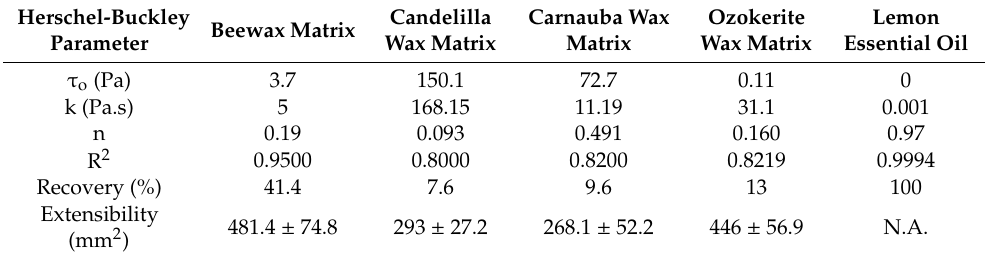
Table 4. Herschel–Buckley parameters and thixotropic recovery from the stress-strain profiles at 25 ◦ C. Candelilla Carnauba Wax Ozokerite Lemon Herschel-Buckley Beewax Matrix Wax Matrix Matrix Wax Matrix Essential Oil Parameter τ o (Pa) 3.7 150.1 72.7 0.11 0 k (Pa.s) 5 168.15 11.19 31.1 0.001 n 0.19 0.093 0.491 0.160 0.97 R 2 0.9500 0.8000 0.8200 0.8219 0.9994 Recovery (%) 41.4 7.6 9.6 13 100 Extensibility 481.4 ± 74.8 293 ± 27.2 268.1 ± 52.2 446 ± 56.9 (mm 2 )